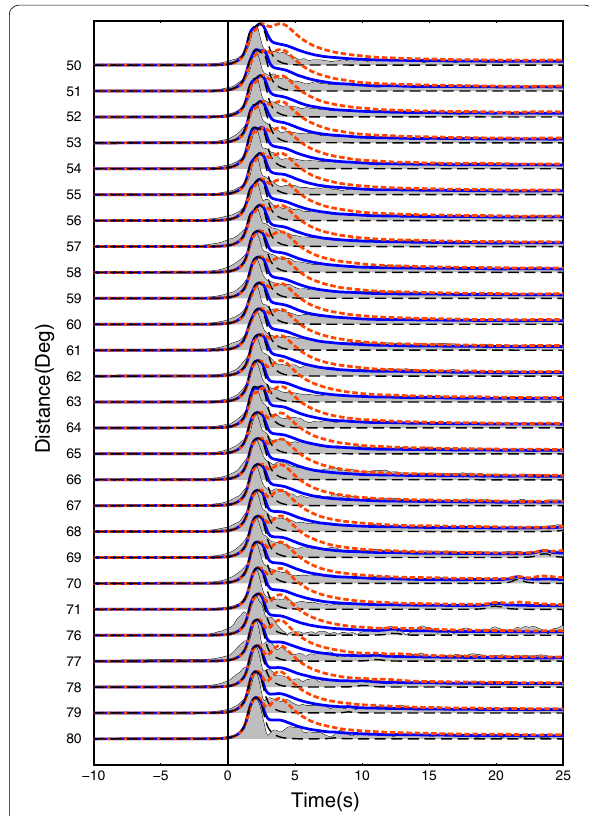
Fig. 12 A comparison of synthetics for similar scattering models to that in Fig. 11, but with a